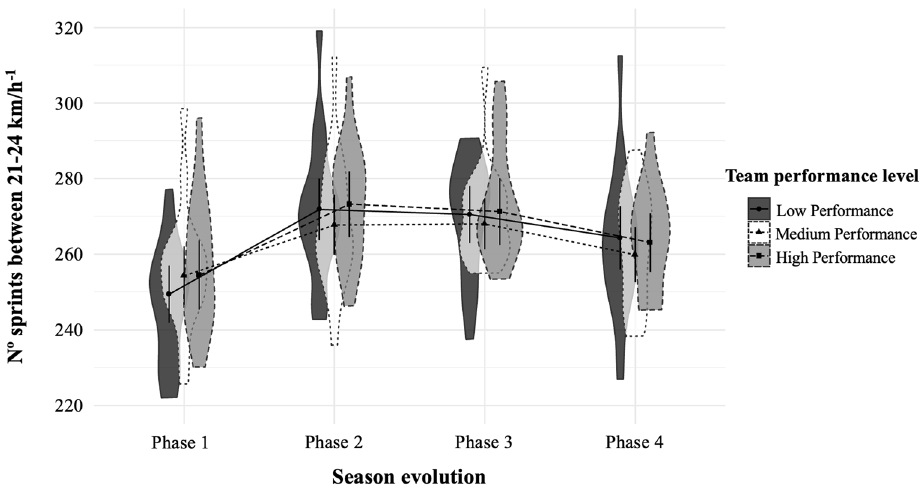
Figure 5. Number of sprints between 21 and 24 km h −1 registered ( M ± SD ) by teams with high, medium and low performance in the different phases of the seasons 29